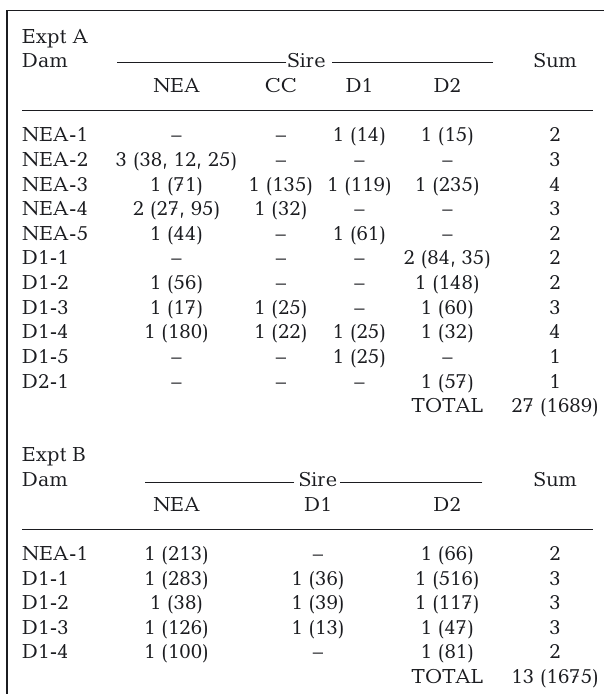
Table 1. Overview of number of Atlantic cod crosses (dam × sire) that were produced to hatch and survived in sufficient numbers to be used in growth calculations (N > 9). Numbers in parentheses indicate number of individuals per cross. The dams are listed as individuals, such that e.g. NEA-1 eggs were split in 2 and fertilized with one D1 and one D2 male. Experi - mental groups are NEA: wild Northeast Arctic cod, CC: wild- caught coastal cod, D1: domesticated cod from the Norwegian national breeding program, D2: domesticated cod from a commercial